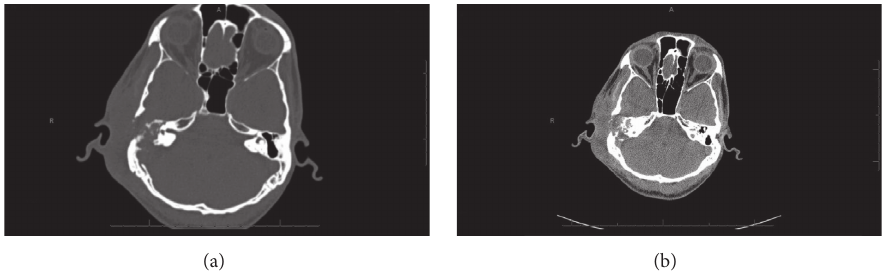
Figure 1: Axial CT scan (noncontrast) showing the temporal bone. (a) Bone window and right ill-defined soft tissue density in the right mastoid air cells, middle, and inner ear, associated with bony destruction. Only the basal turn of the cochlea and part of the vestibule are visualized. (b) Soft tissue window and posterior aspect of the tegmentum tympani appear destroyed, thinned, and interrupted, with subcutaneous soft tissue swelling adjacent to the EAC and collection at the superior